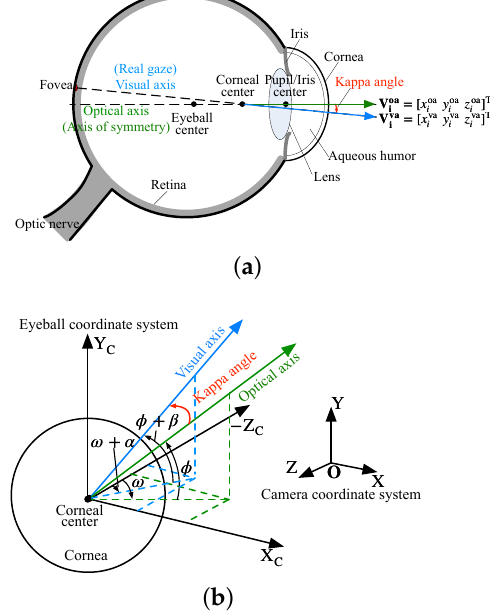
Figure 1. Kappa-angle representations. ( a ) Using a transformation matrix. ( b ) Using a horizontal angle and a vertical